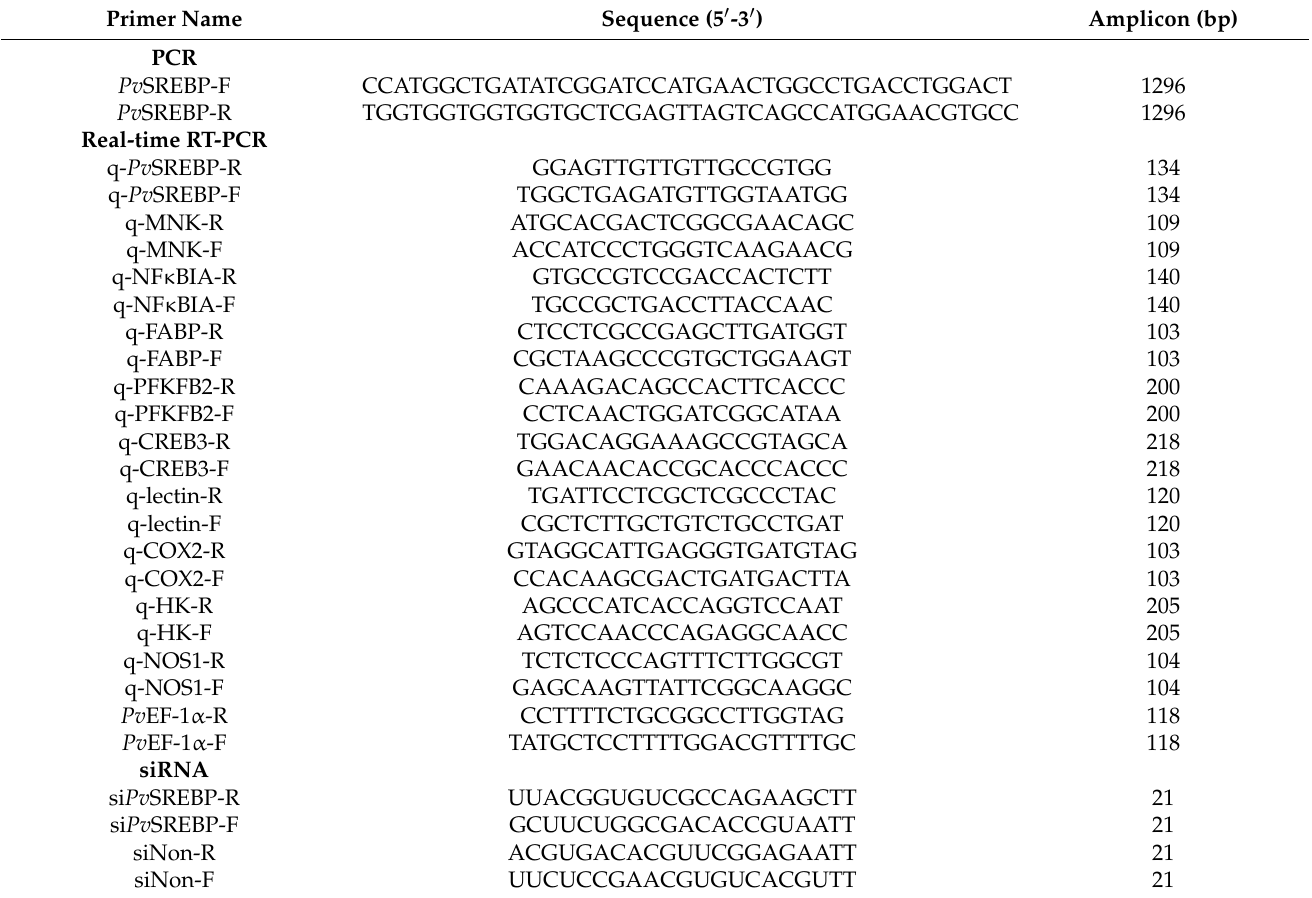
Table 1. The gene-specific primer